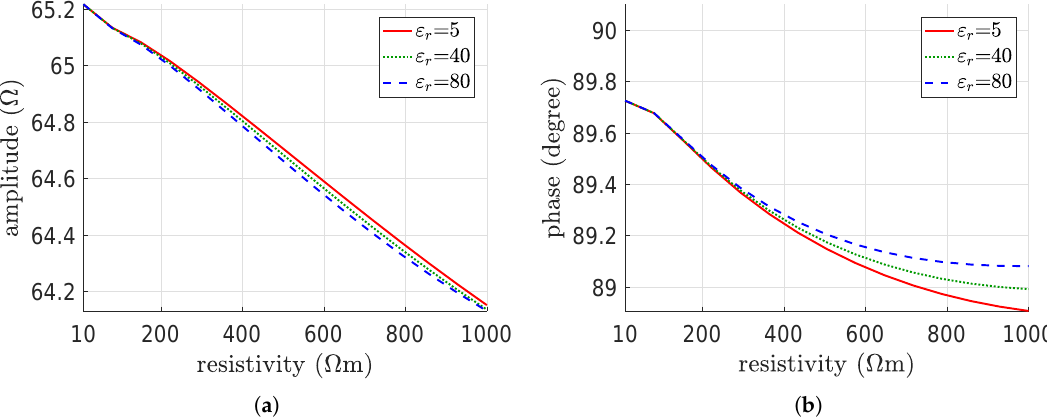
Figure 20. Equivalent impedance of the embedded coil ( Mod3 ) at 50 kHz for a concrete resistivity from 10 Ω m to 1000 Ω m, parametrized for ε r equal to 5, 40, and 80. Amplitude ( a ); phase ( b ).